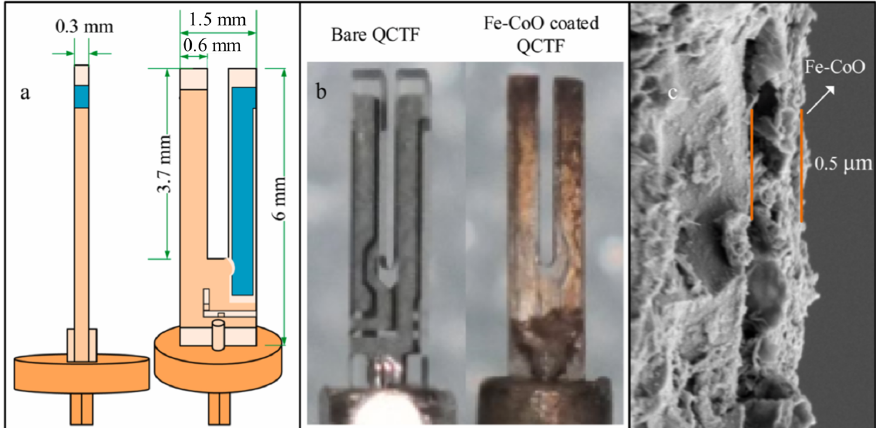
Figure 8. ( a ) Geometric configuration of the QTF. ( b ) Photo of the bare QTF and the Fe–CoO-coated QTF. ( c ) TEM (transmission electron microscopy) image of the Fe–CoO-coated QTF. Reproduced with permission from Ref. [113]. Copyright 2021, copyright Elsevier.